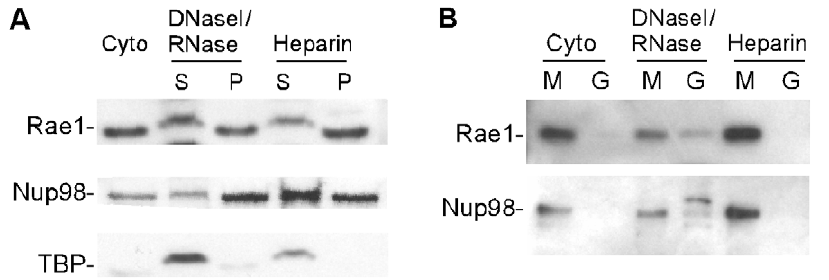
Figure 10. Interaction of M protein with Rae1 and Nup98 in nuclear chromatin-associated fractions. HeLa cells were lysed in hypotonic buffer and separated into nuclei and cytoplasm (Cyto). Nuclei were fractionated as described in [36]. ( A ) Supernatant (S) and pellet (P) fractions were analyzed by immunoblots probed for the presence of Rae1, Nup98, and TATA-binding protein (TBP). ( B ) Supernatant fractions from ( A ) were incubated with GST-M protein (M) or GST (G) on glutathione beads. Bound fractions were analyzed by immunoblots probed for Rae1 and